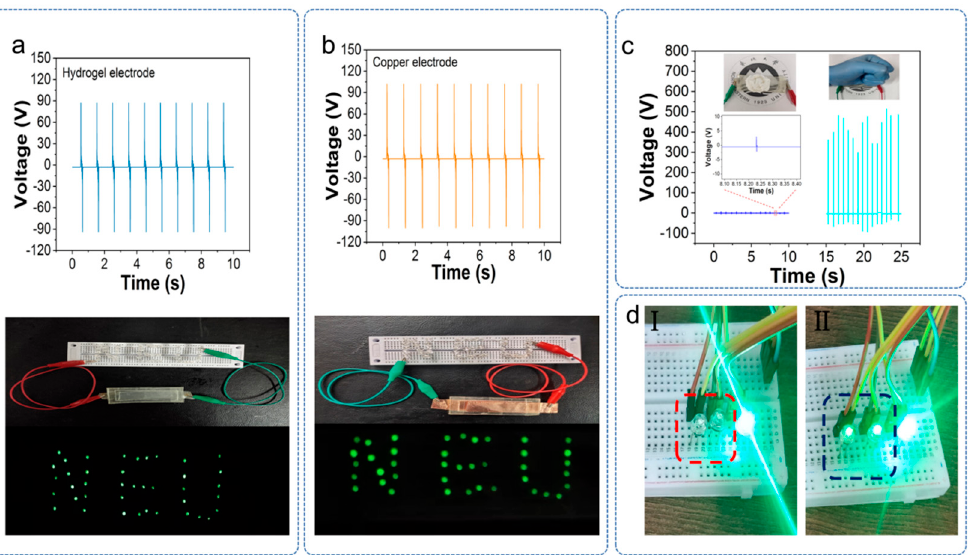
Figure 4. Output performance, sensitivity and wireless sensing tests of the hydrogel electrode FL ‐ TENG. ( a ) Hydrogel electrode output voltage and lighting of 40 green LEDs. ( b ) Output voltage of copper electrode and lighting of 40 green LEDs. ( c ) Sensitivity test of FL ‐ TENG. ( d ) Wireless Bluetooth transmission test. (I) LED lights are not lit up. (II) LED lights are lit up.